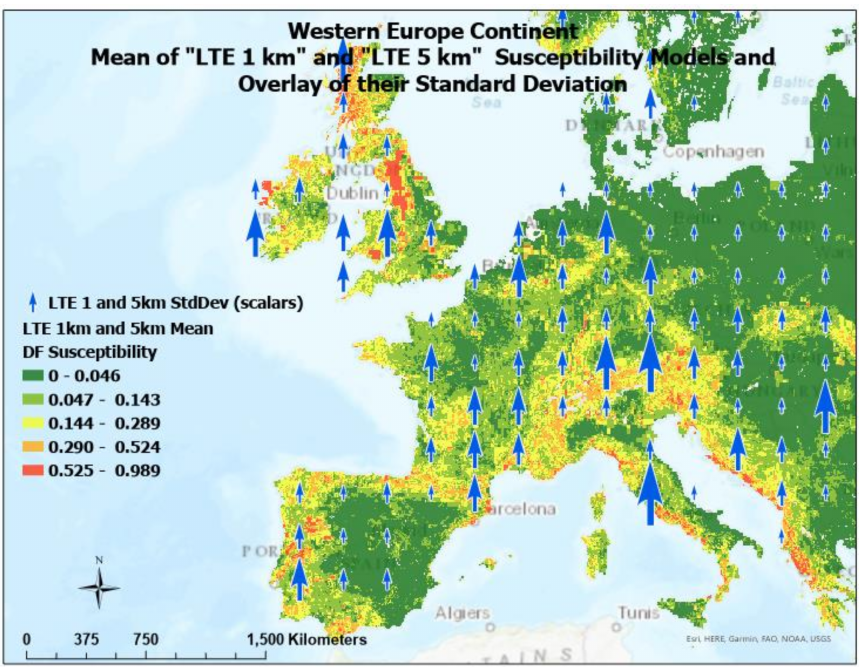
Figure 9. Overlay of susceptibility standard deviation and mean for two combined models (“LTE 5km” and “LTE 1km”) zoomed into western Europe for detail. Standard deviation is represented by a scalar (blue arrows), small arrows = low values, etc. Warmers colors represent higher mean susceptibility. Base map is from ArcGIS ® , the intellectual property of Esri, used herein under license. Copyright© Esri.